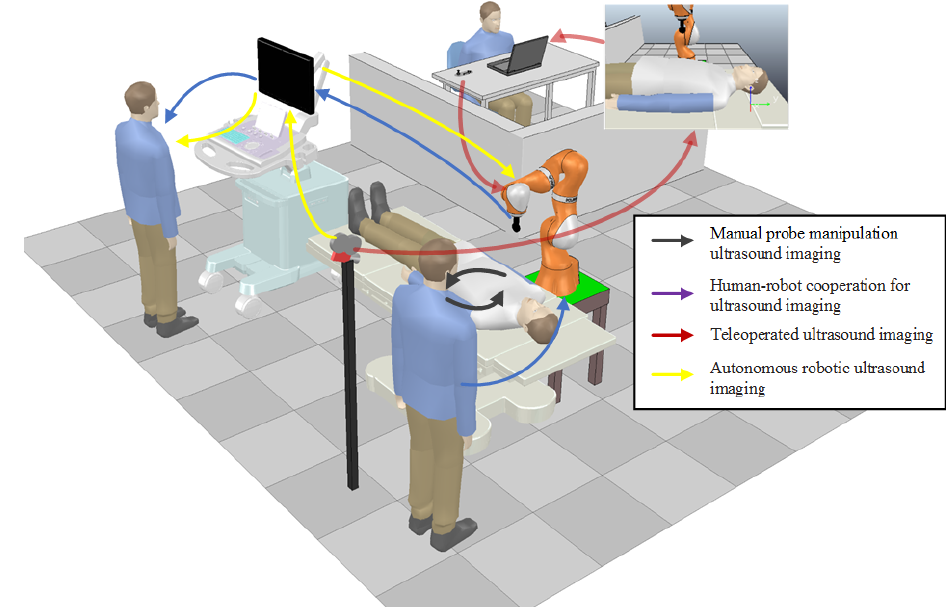
Figure 1. Robot-assisted ultrasonic examination system classification by the level of